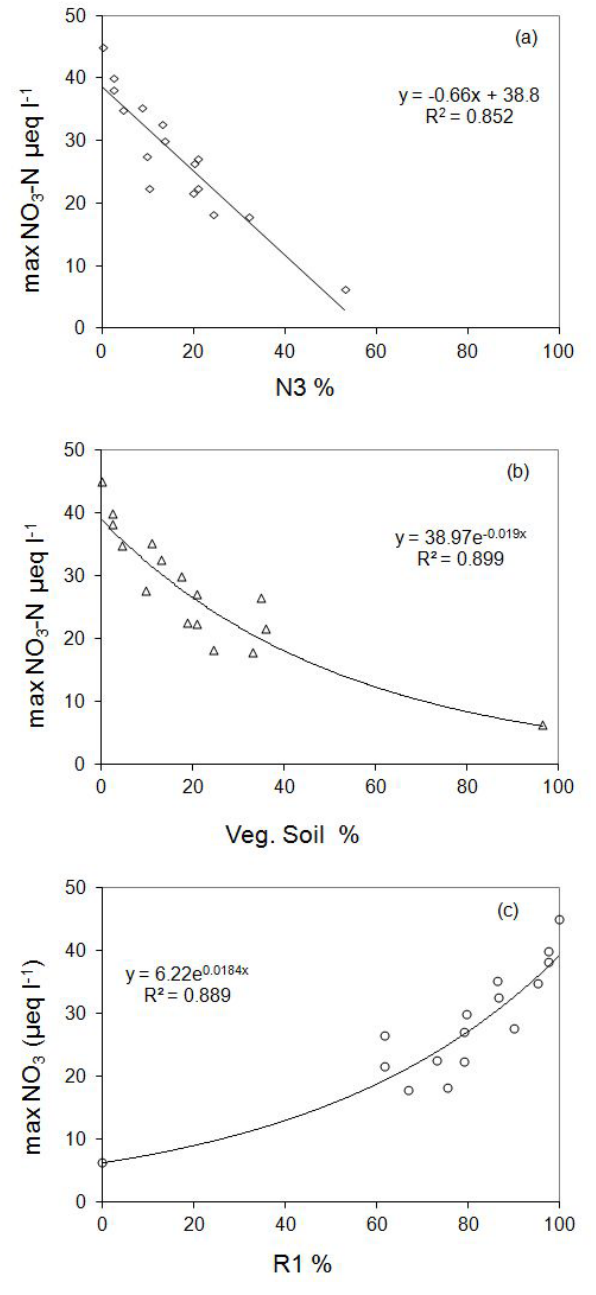
Fig. 6. Relationship between the maximum NO 3 concentration in catchment outflow and (a) tundra (N3) percentage (b) vegetated soil percentage and (c) talus and bedrock (R1) percentage, for high- elevation watersheds of the Val Masino.